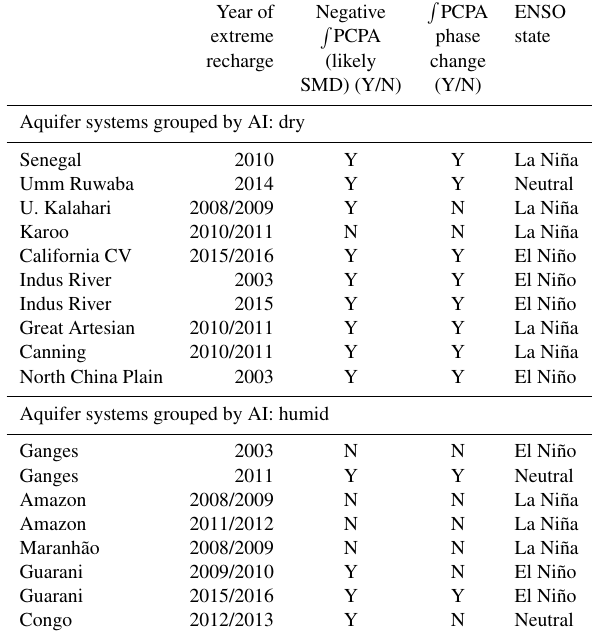
Table 5. Aquifer systems grouped by AI – dry (upper) and humid (lower). Extreme recharge years identified from annual time series by slope of (cid:49) GWS plotted line. SMD status inferred by prior neg- ative (cid:82) PCPA and annual (cid:82) PCPA phase change also derived from the same time series. ENSO state from NINO3.4 Index (B. Huang et al.,